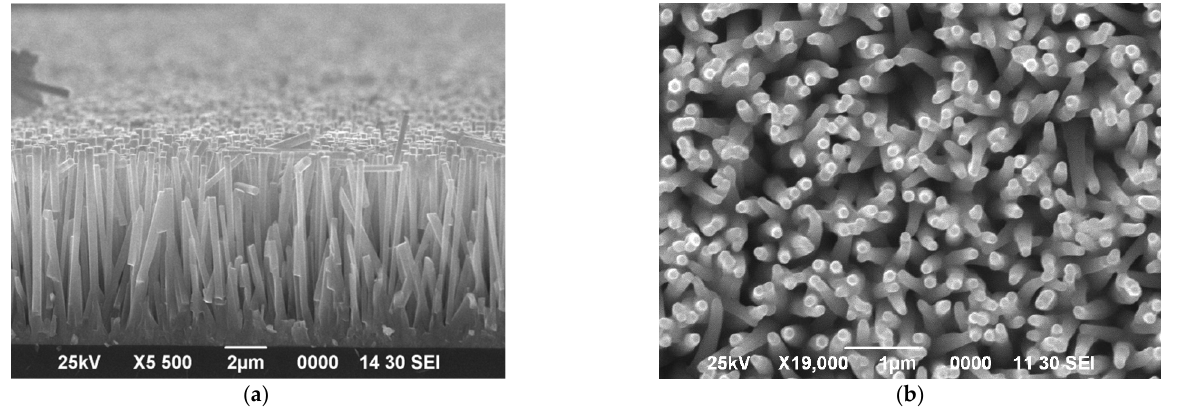
Figure 1. Typical SEM images of array of 10 μ m length NRs, ( a ) cross-section and ( b ) planar views.